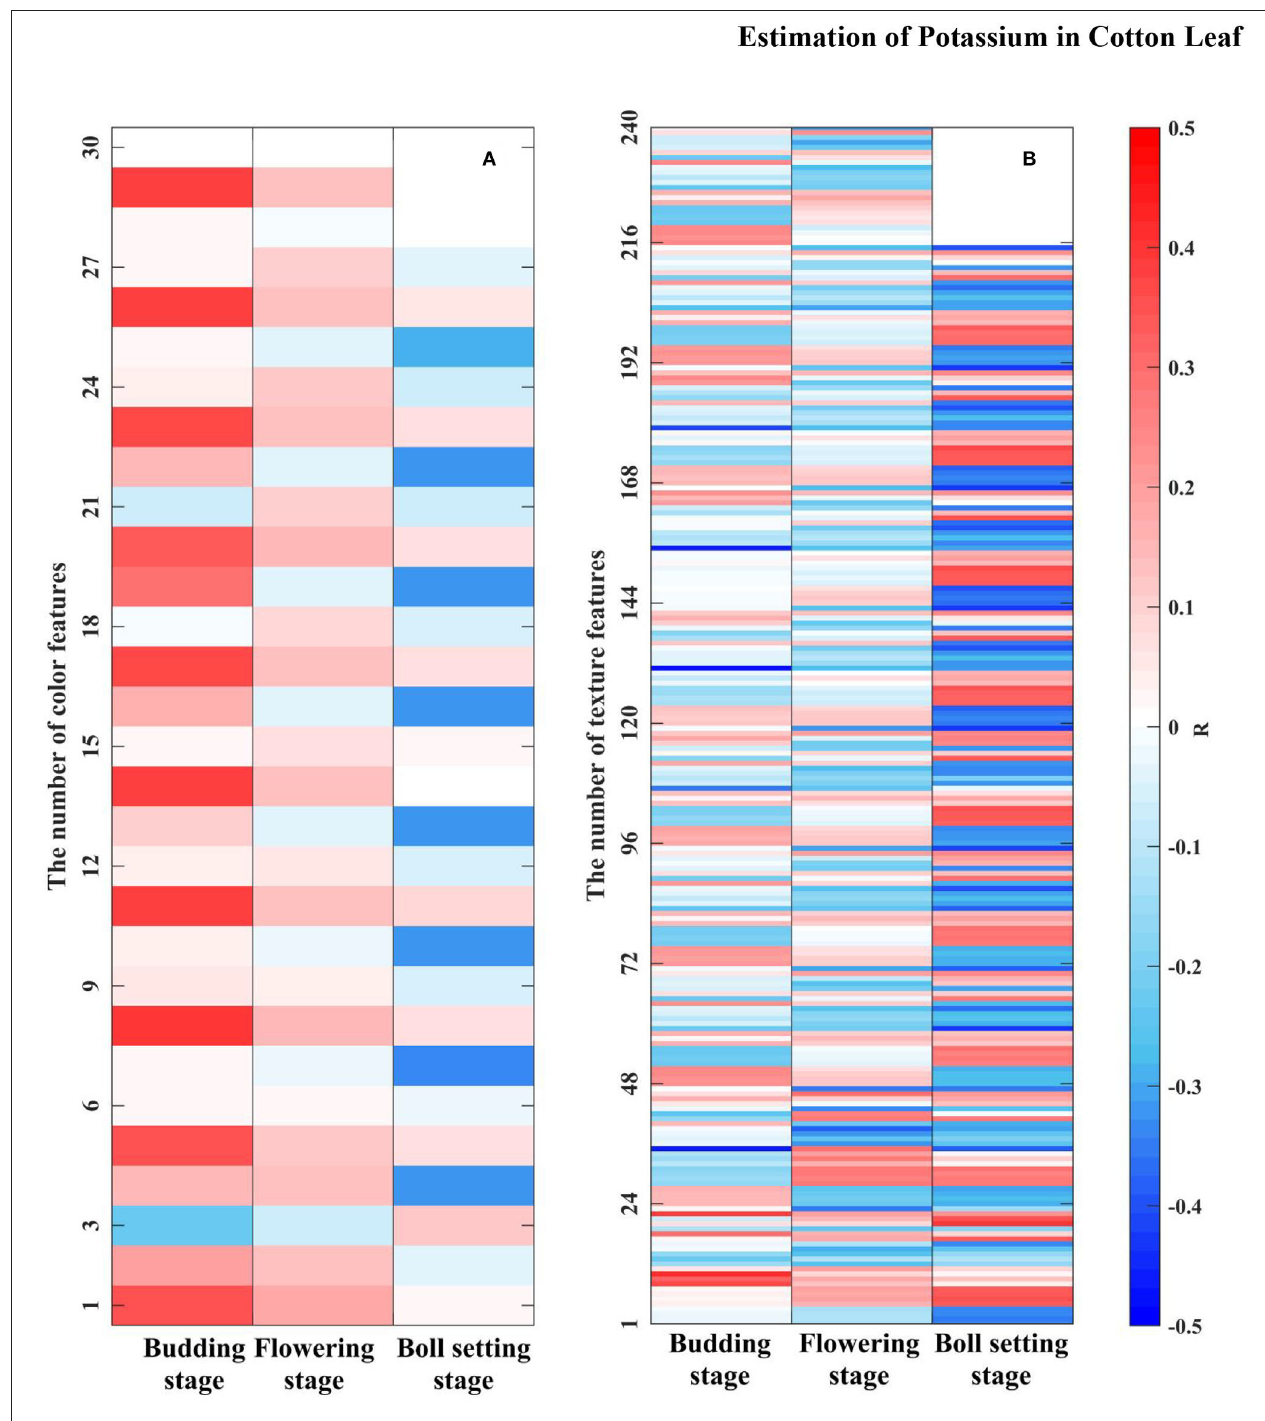
FIGURE 9 | Correlation analysis of the LKC with grayscale image features. (A) Color features. There were 10 stages, respectively. (B) Texture features. There were 10